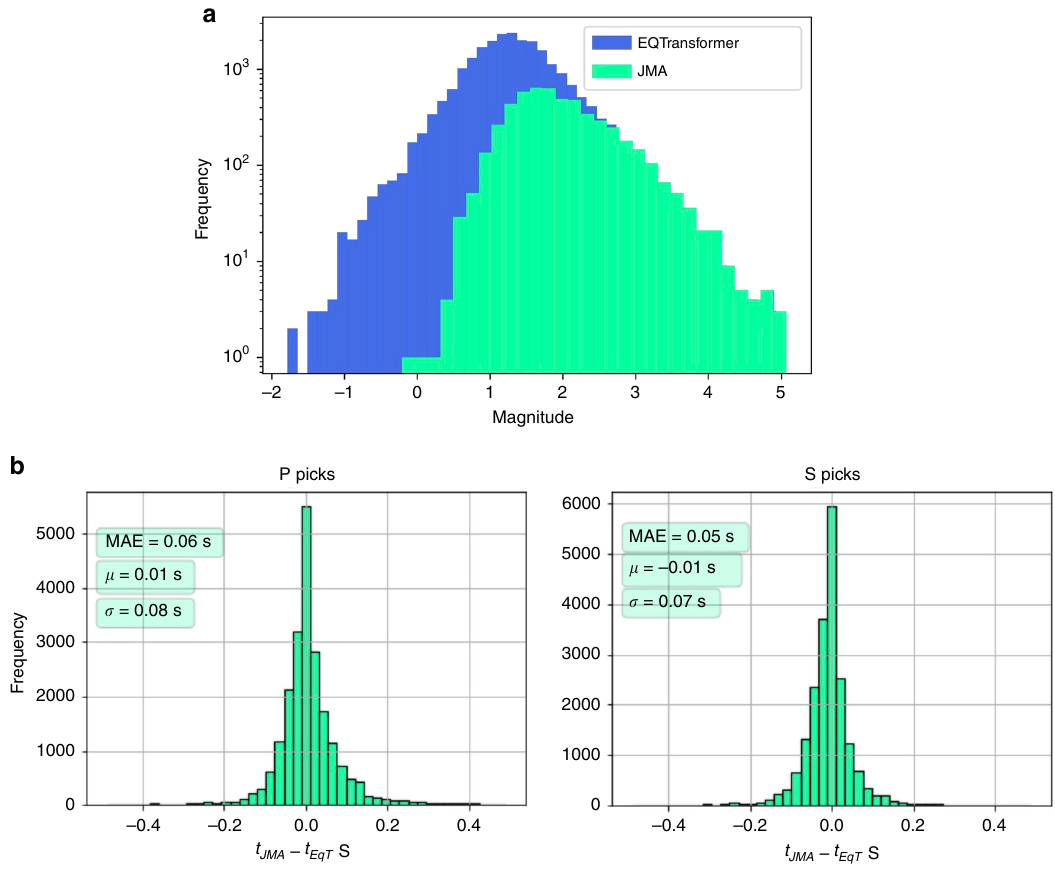
Fig. 6 Distributions of frequency magnitude of earthquakes and picking errors. a frequency-magnitude distributions of located events in JMA catalog and relocated events in our catalog (EQTransformer). Magnitudes for all events have been estimated using a local magnitude scale. b distributions of arrival-time differences (in second) between P (left) and S (right) picks by JMA ʼ s analysts and